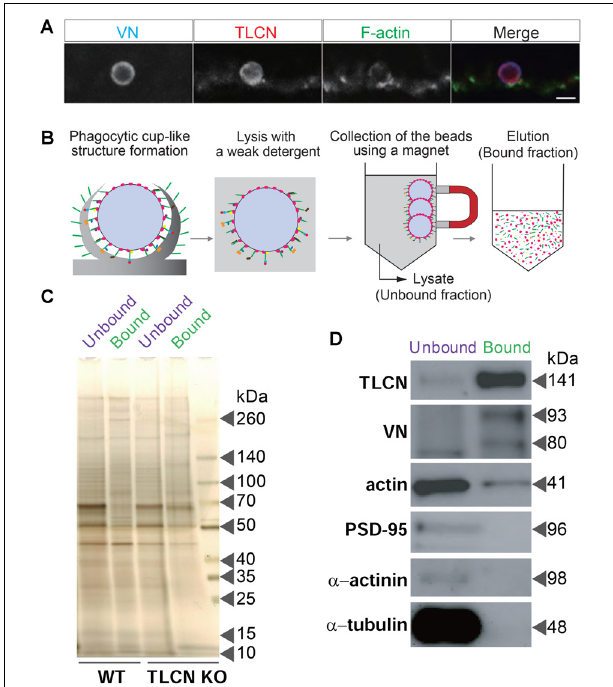
FIGURE 2 | Purification of proteins enriched in dendritic phagocytic cups. (A) A dendritic phagocytic cup induced by a magnetic microbead attached onto a neuronal dendrite and immunostained with anti-VN antibody (blue in merged images of A ), anti-TLCN antibody (red in merged images of A ), and phalloidin (green in merged images of A ). Scale bar, 2 µ m in (A) . (B) A schematic diagram illustrating the purification procedure of dendritic phagocytic cup fraction. Magnetic microbeads were added onto cultured hippocampal neurons to induce the formation of dendritic phagocytic cups. After 1 day of incubation, neurons was solubilized with lysis buffer containing 0.01% Triton X-100. The beads were separated from unbound fraction using a magnet. After washing, bound proteins were eluted with SDS-containing buffer. Red: VN, green: TLCN, other colors: bound proteins. (C) Silver staining of proteins in the microbeads-unbound and bound fractions. Same amount (50 ng) of proteins in the unbound and bound fractions purified from wild-type (WT) and TLCN-deficient (TLCN KO) hippocampal neurons were separated by SDS-PAGE and visualized with silver staining. (D) Western blot analysis of the unbound and bound fractions. Same amount (50 ng) of proteins were separated by SDS-PAGE and subjected to Western blot analysis using anti-TLCN, anti-VN, anti-actin, anti-PSD-95, anti- α -actinin, and anti- α -tubulin antibodies. Molecular weights of individual proteins were estimated from molecular weight markers and shown on the right. Note that TLCN, VN (arrow heads), and actin are observed in the dendritic phagocytic cup